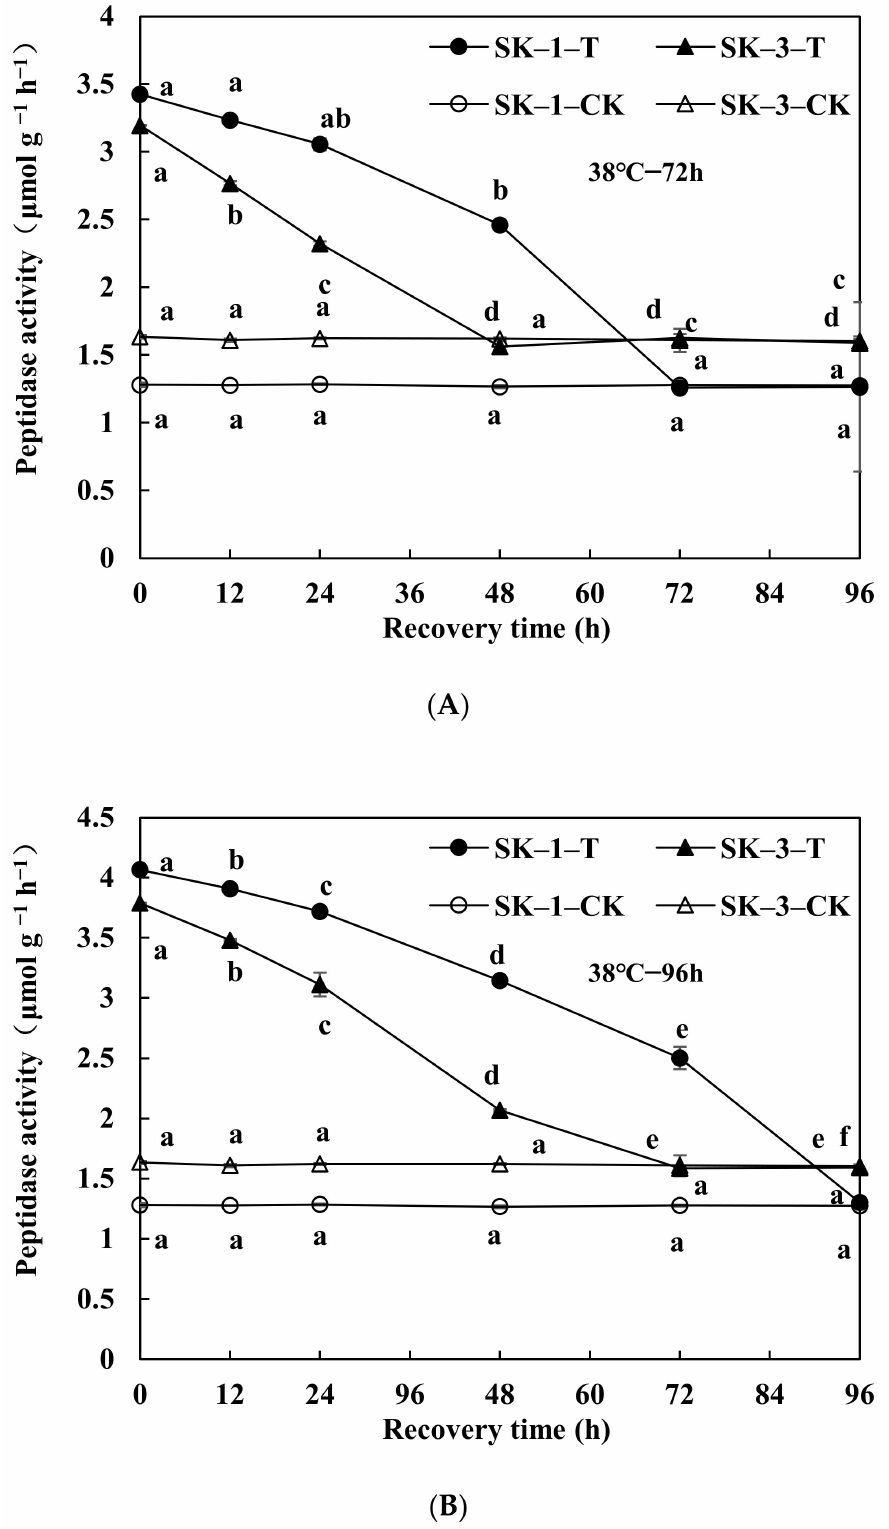
Figure 7. Changes in peptidase activities in squares of Bt cotton after 72 h ( A ) and 96 h ( B ) high- temperature stress termination. Peptidase activity at the recovery time with different lowercase letters is significantly different from the control at p < 0.05 under the same high-temperature stress duration for the same cultivar. T—treatments for 72 h ( A ) and 96 h ( B );